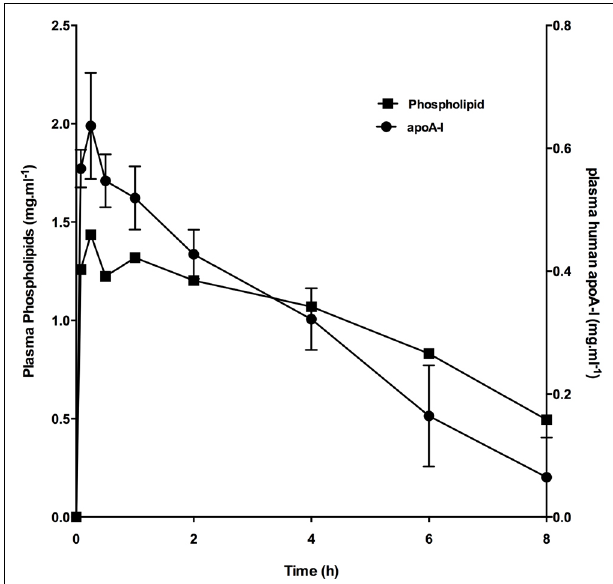
FIGURE 1 | Increase in plasma phospholipid and apoA-I following infusion of CER-001. CER-001 (20 mg/kg) was infused into fasted rabbits. There were three animals per group. At various times post dose, plasma phospholipid and apoA-I levels were measured. Plasma human apoA-I levels were measured by a human apoAI-specific enzyme-linked immunosorbent assay (ELISA). Baseline values 1.17 g/l were subtracted to determine the increase in plasma phospholipid levels. The values had returned to baseline levels by 30–34 h post